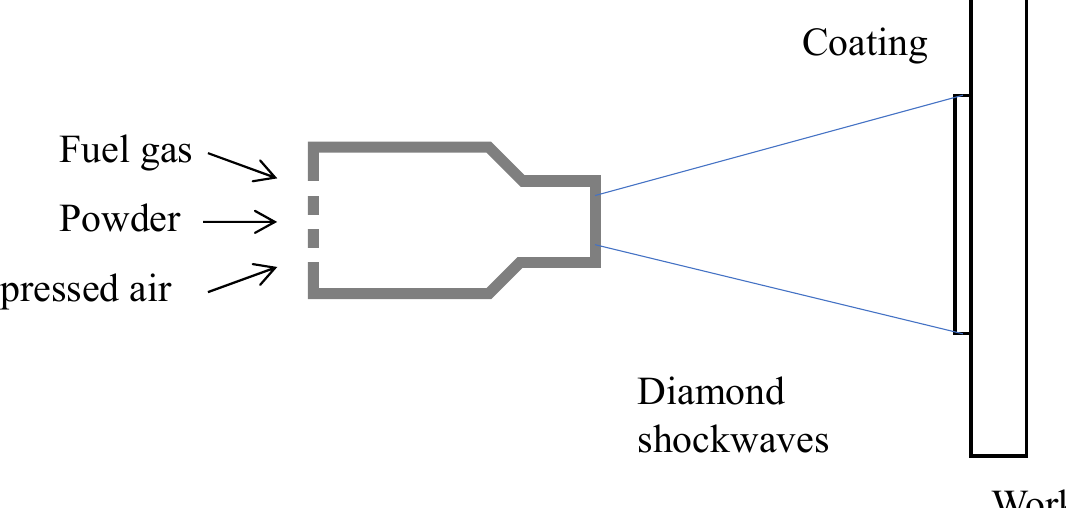
Figure 1. Two sides of the new surface treatment method. ( a ) Inner plate (HVOF-coated). ( b ) Cover plate (grit-blasted).